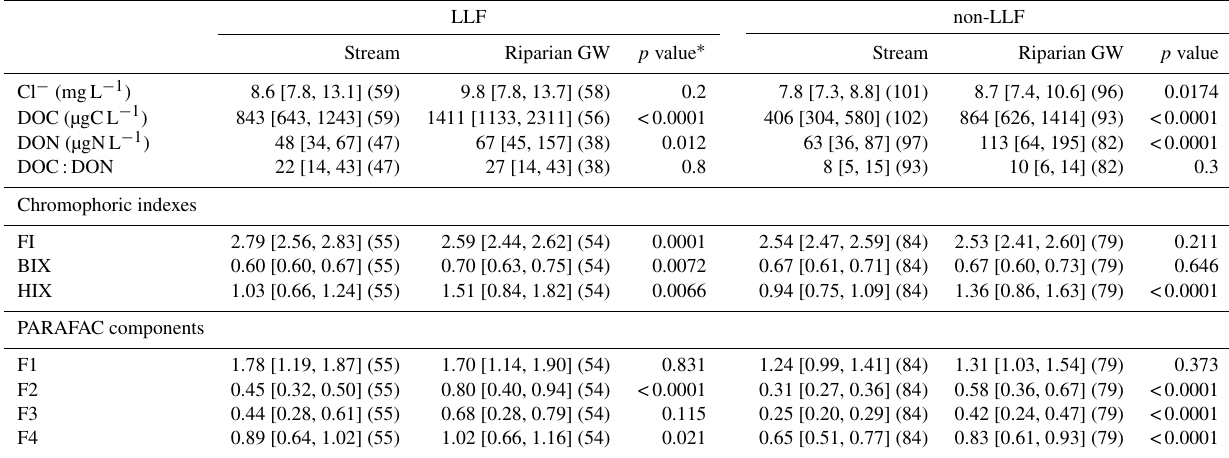
Table 1. Characterization of chloride (Cl − ) and dissolved organic matter (DOM) (both concentrations and quality) in the main stream and in riparian groundwater (riparian GW) for the leaf litter fall (LLF) period and the non leaf litter fall (non-LLF) period at Font del Regàs. Values are medians and interquartile ranges [25th, 75th percentiles] for dissolved organic carbon (DOC) and dissolved organic nitrogen (DON) concentrations, DOC:DON molar ratio, fluorescence index (FI), humification index (HIX), biological index (BIX), and the four PARAFAC components (F1, F2, F3, and F4). The number of cases is shown in